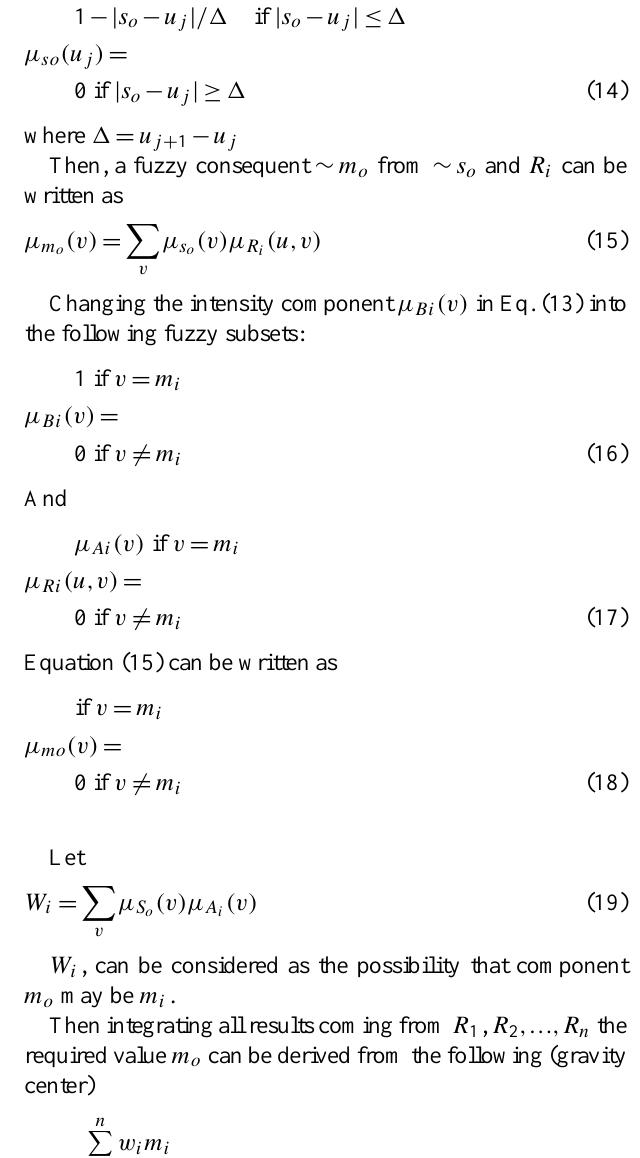
Fig. 5. Fuzzy rule “IF u = A THEN v = B ” through observation s i ,m i using information